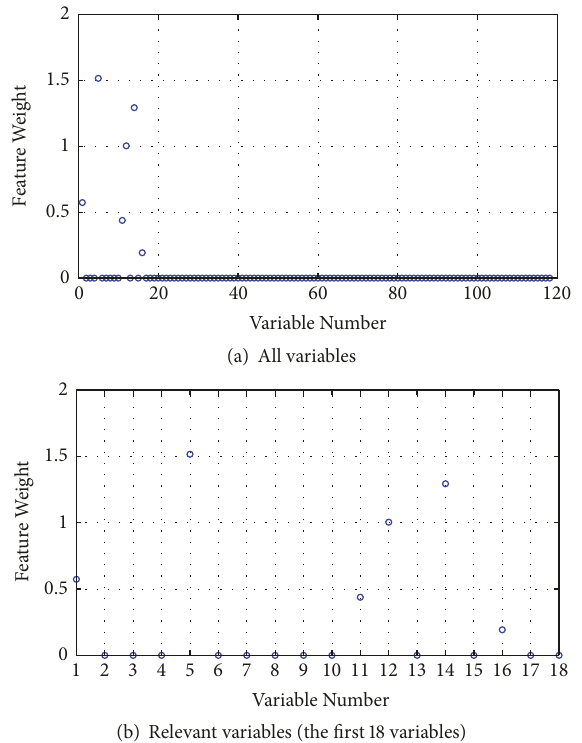
Figure3:Thefeatureweightsofvariables(afterparameteroptimiza- tion).